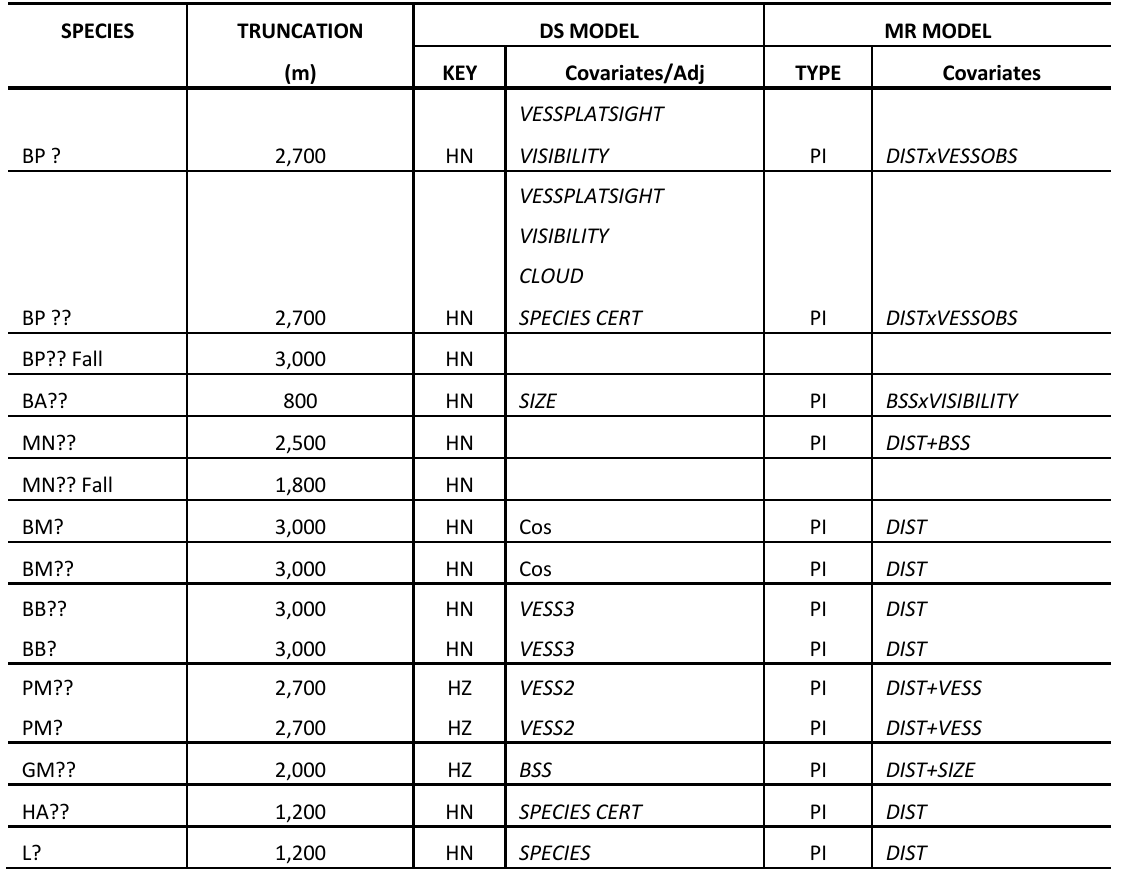
TOT TOT Table 3. Model specifications for abundance estimates. Species definitions are given in Table 2. DS Model – Distance model; MR Model – Mark recapture model. PI – point independence; HN – half-normal; HZ – hazard rate; Covariate definitions: DIST – perpendicular distance; VESSPLATSIGHT – vessel platform which made the sighting; VISIBILITY – approximate visibility in km; CLOUD – proportional cloud cover; VESSOBS – vessel observing team making the sighting; SPECIES CERT – species identification certainty, 3 levels; BSS – Beaufort sea state; VESS2 – vessel identity, vessels A and B combined; VESS3 – vessel identity, vessels A and H combined; Adj. – adjunct; Cos - cosine adjunct. SPECIES TRUNCATION DS MODEL MR MODEL (m) KEY Covariates/Adj TYPE Covariates